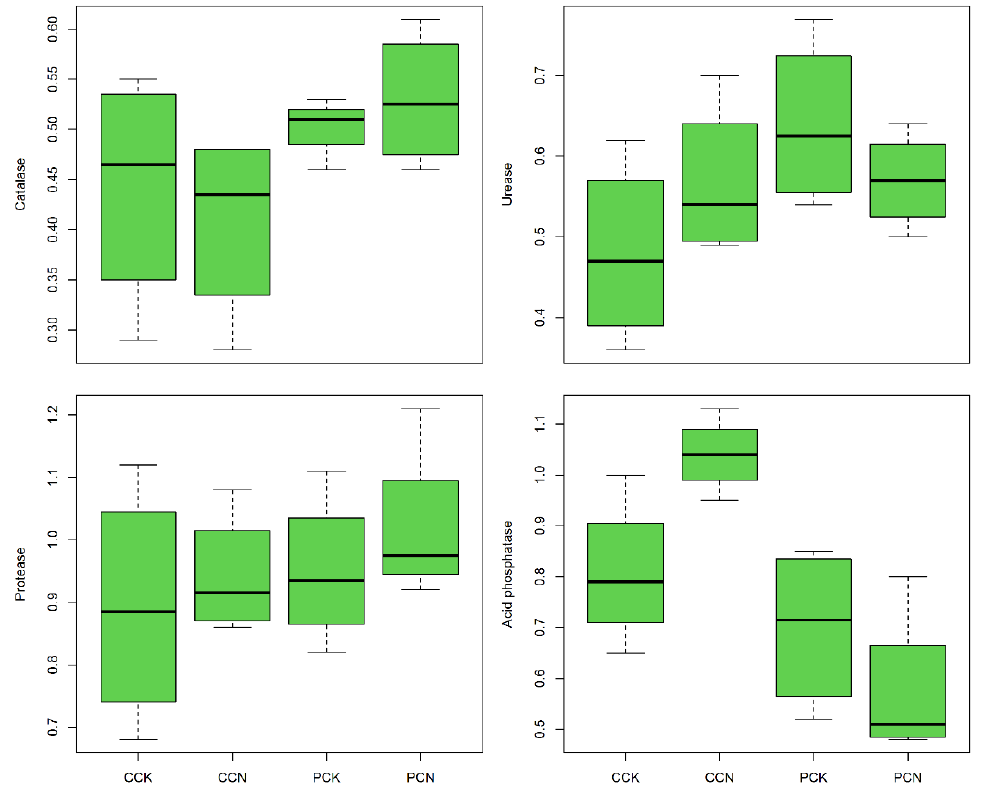
Figure 2. Characteristics of soil enzyme activities after close-to-nature transformation (0–10 cm). CCK, CCN, PCK, and PCN represent the control and close-to-nature transformation of C. lanceolata plantation and the control and close-to-nature transformation of P. massoniana plantation, respectively.